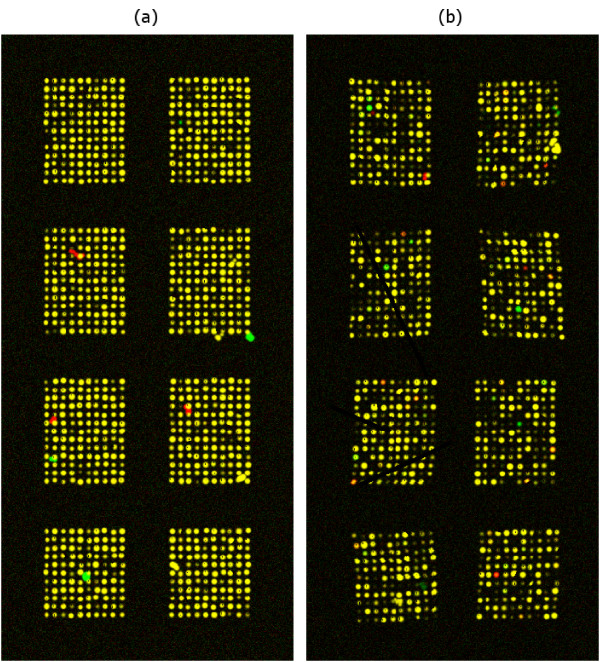
Simulated spotted microarray slide images. Simulated slide images at time instants (a) 10 and (b) 200 minutes. Several error sources, like spot size and shape variation and bleeding are included in simulation. On the slide image on the right (b) also unideal subarray alignment and scratches are introduced.